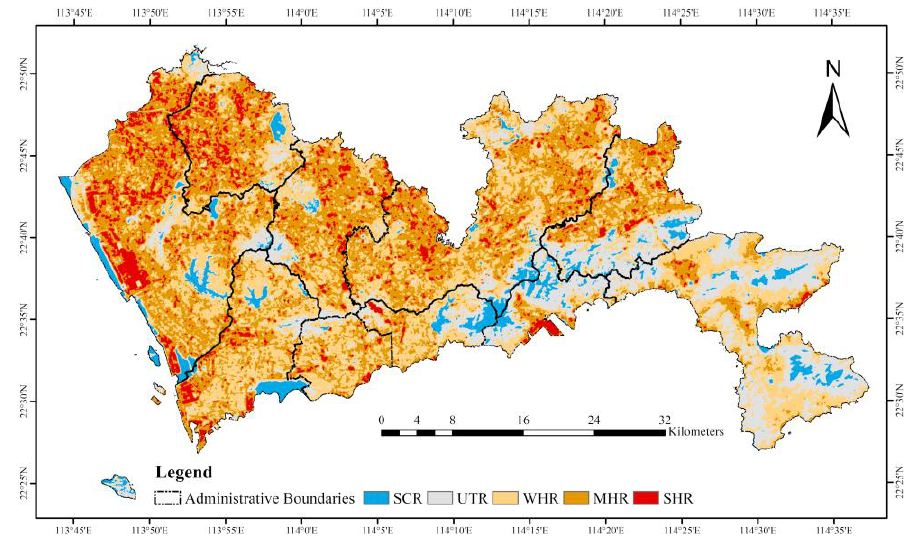
Figure 7. Thermal effect levels distribution in Shenzhen. SCR: significant cooling effect region; UTR: unnoticeable thermal difference region; WHR: weak heat effect region; MFR: moderate heat effect region; SHR: significant heat effect region.